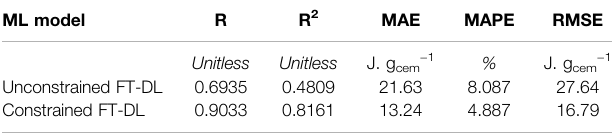
TABLE 3 | Statistical parameters describing the errors in predictions of 24 h cumulative heat release, as produced by the unconstrained and thermodynamically-constrained FT-DL